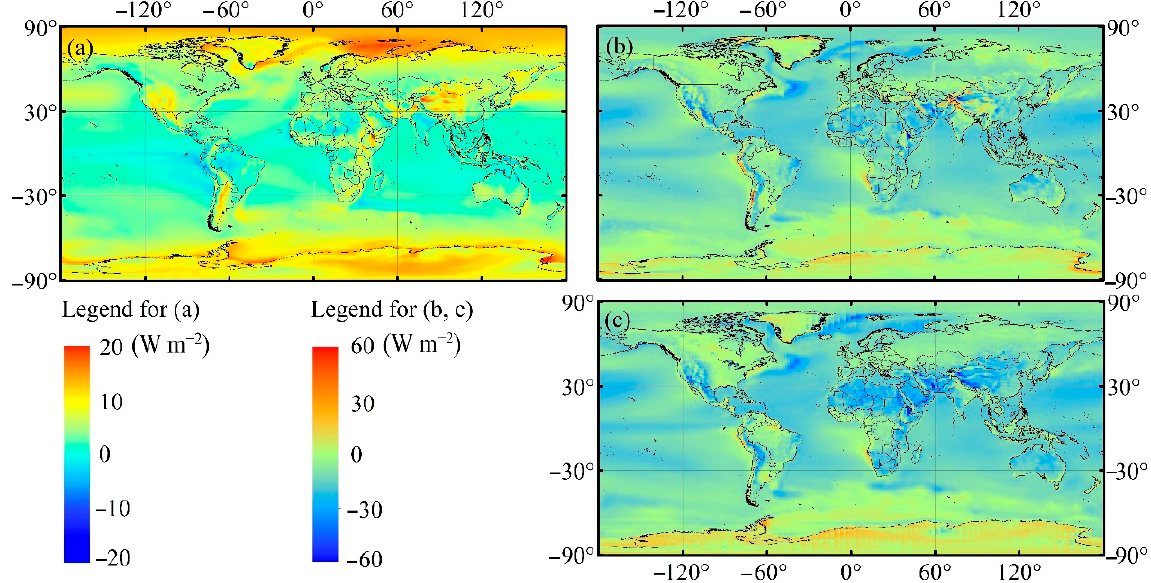
Figure 9. The biases of the SULR estimations between CMIP6 GCMs and CMIP5 GCMs ( a ), between CMIP6 GCMs and ERA5 ( b ), and between CMIP6 GCMs and CERES EBAF ( c ) from 2000 to 2005 (the SULR estimations from CMIP6 and CMIP5 GCMs were obtained by the BMA method, in units of W m − 2 ).